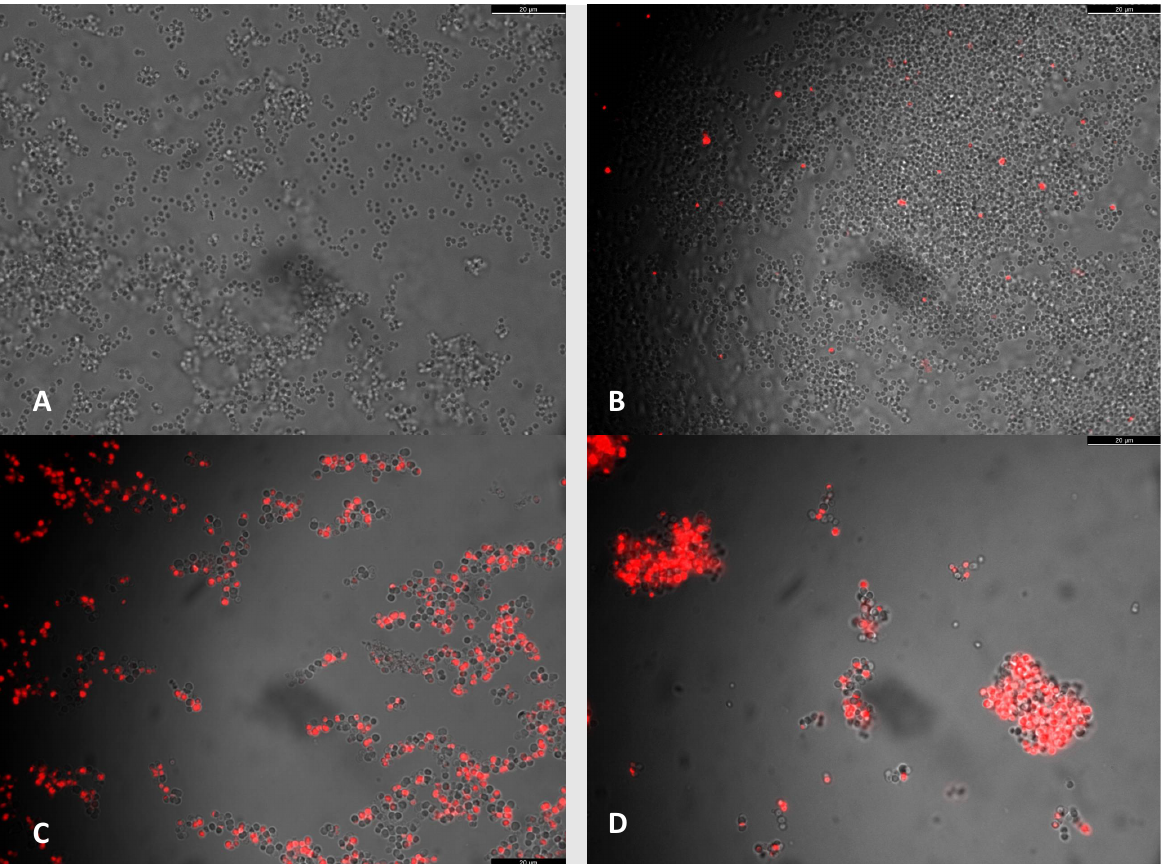
Figure 5. Phase-contrast and fluorescent microscopy of S. aureus CECT435. ( A ) Control strain grown in BHI liquid at 3 h. ( B ) Control strain incubated in brain heart infusion (BHI) liquid media supplemented with icariin to a final concentration of 30 µg/mL at 3 h. ( C ) Control strain incubated in BHI liquid media supplemented with AmoxyClav at 3 h. ( D ) Control strain incubated in BHI liquid media supplemented with icariin + AmoxyClav.